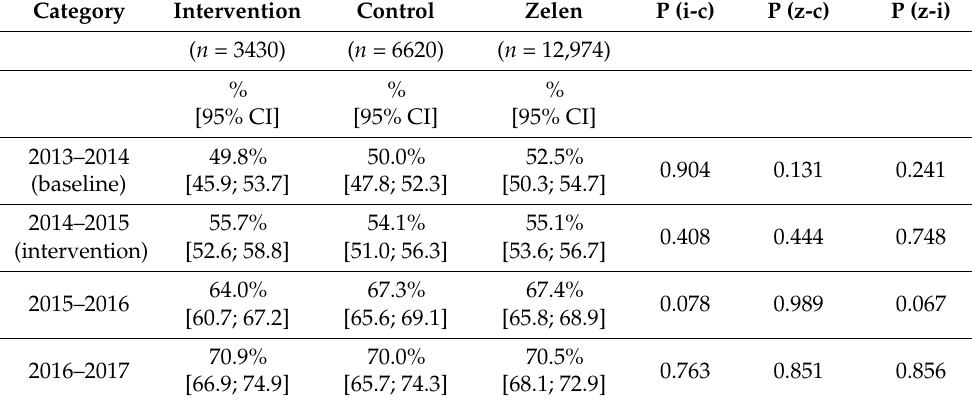
Table 2. Influenza vaccination uptake in the three groups during three years after baseline.